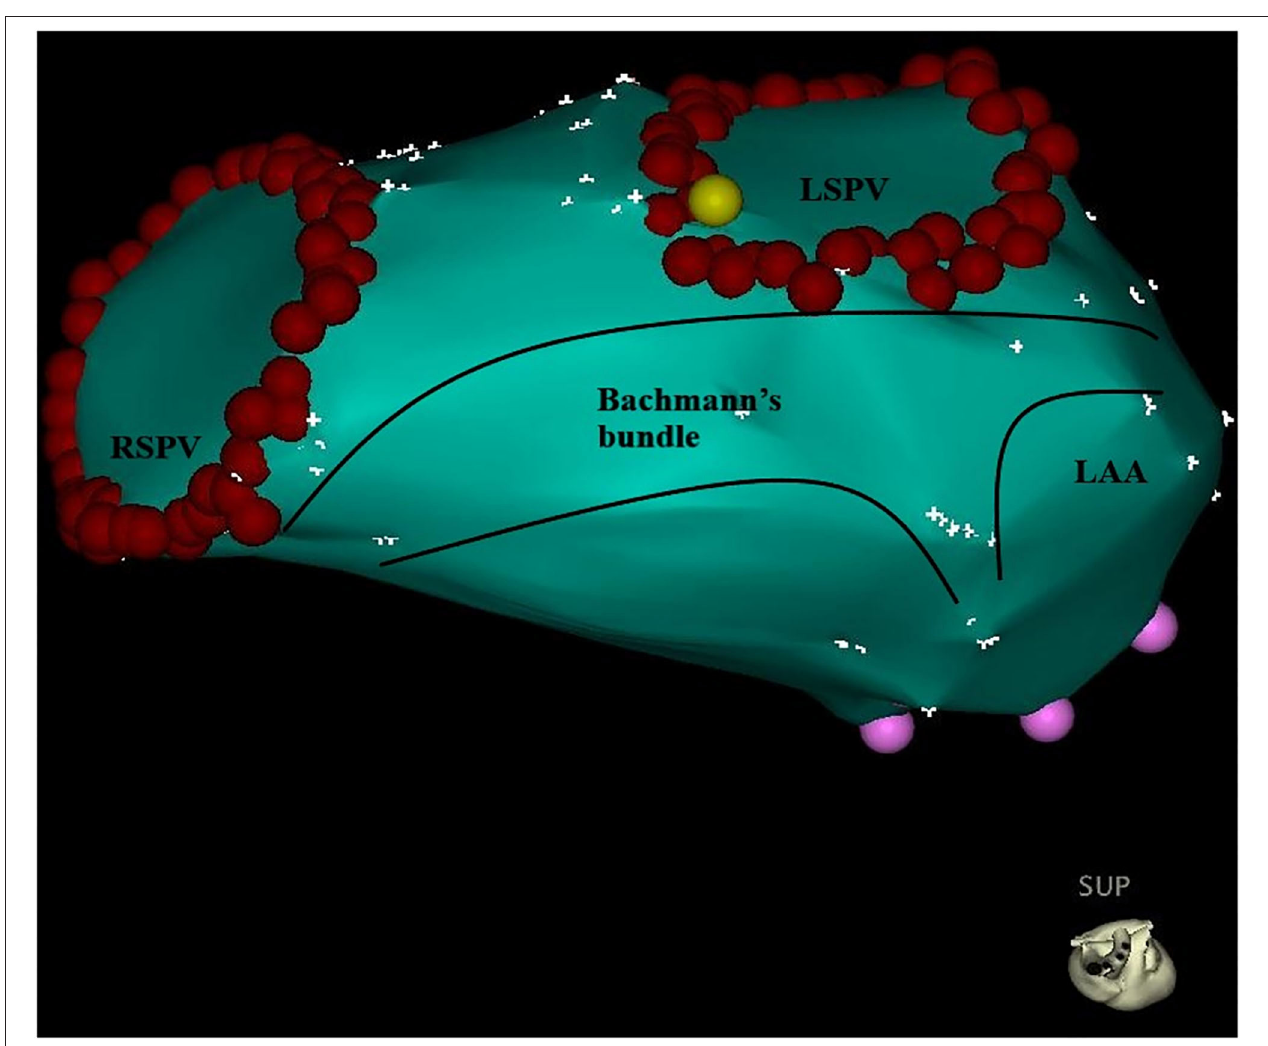
FIGURE 5 | Bachmann’s bundle branches to the left atrium and passes around the neck of the left atrial appendage, reuniting to continue into the musculature of the lateral and posteroinferior atrial walls. The red point represents the pulmonary vein ostium. LSPV, left superior pulmonary vein; RSPV, right superior pulmonary vein; LAA, left atrial